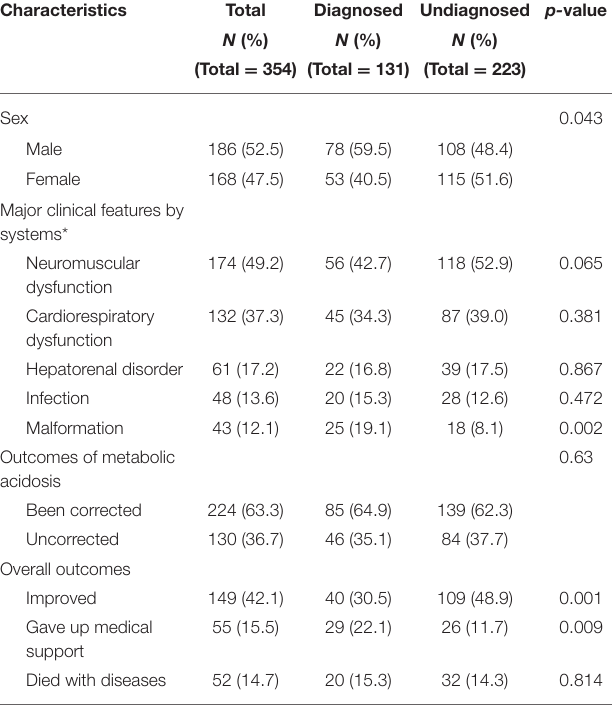
TABLE 1 | Demographic features and phenotypes of NMA patients tested with